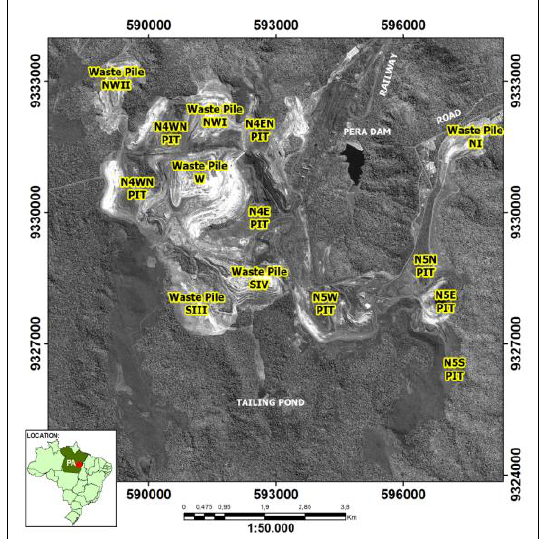
Figure 1. Location of Carajás iron complex in the Brazilian Amazon region (Pará State), showing the open pits, waste piles and related mining